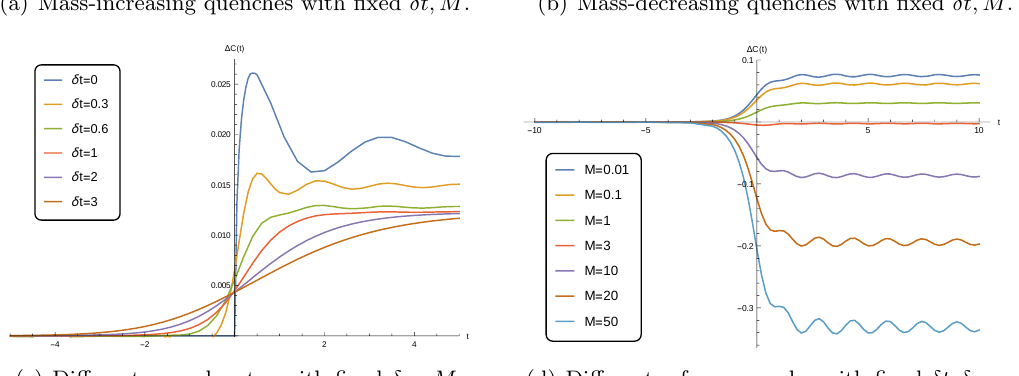
(d) Di(cid:11)erent reference scales with (cid:12)xed (cid:14)t; (cid:14)m . Figure 1 . Time dependence of the complexity for many combinations of the mass di(cid:11)erence (cid:14)m = m out (cid:0) m in , the quench rate (cid:14)t , and the scale M characterizing the reference state. All the plots were made with speci(cid:12)c numerical values of the parameters chosen for presentation purposes, but the qualitative behavior above was checked to hold generically. Figure (a) has (cid:14)t = 1 ; M = 2 ; m in = 1 and m out is changed as indicated by the inset; (b) has (cid:14)t = 1 ; M = 2 ; m in = 6 and varying m out ; (c) has m in = 1 ; m out = 2 ; M = 2 and varying (cid:14)t ; and (d) was made with m in = 1 ; m out = 2 ; (cid:14)t = 1 while M was